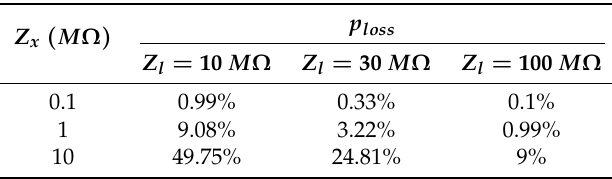
Table 1. Fluid-velocity signal loss in the parallel electrical excitation mode.